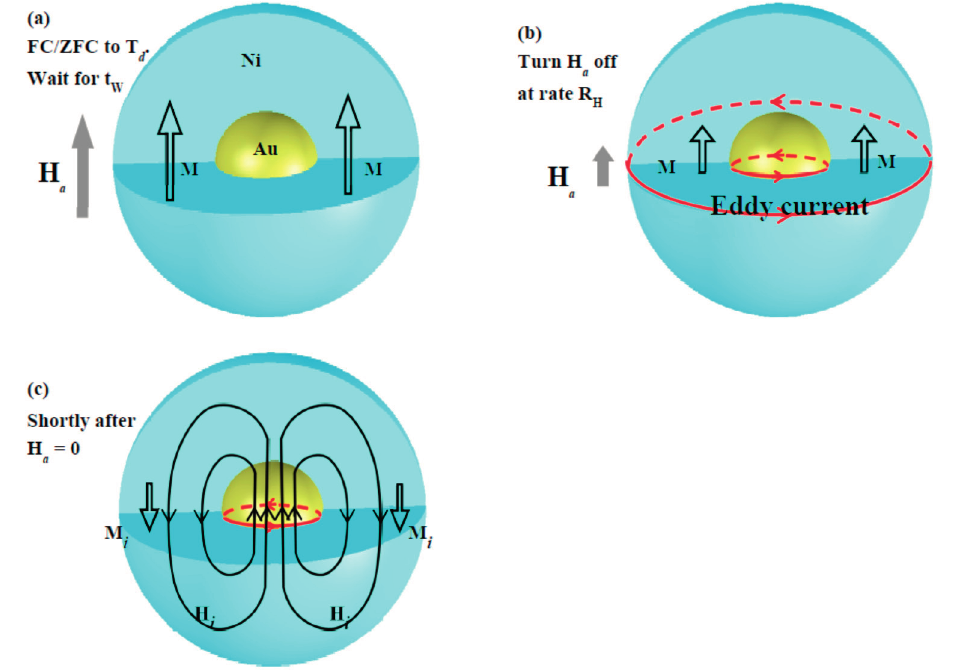
Figure 4. Schematic representations of the applied magnetic field H a , induced eddy current, induced magnetic field H i and magnetization M that developed in the Au@Ni nanoparticle in three representative stages: ( a ) after field-cooling or zero-field-cooling to the designated temperature and after waiting for a designated period of time, where the Ni moments are aligned by the H a and giving rise to an M; ( b ) at an intermediate time as H a is being cut off, where counterclockwise circulating eddy currents (red circles) have been induced in the Au core and in the Ni shell; and ( c ) shortly after H a reaches zero, where the eddy currents in the Ni shell have dissipated while those in the Au core (with a lower resistivity) are still circulating to produce an inverse magnetic field H i